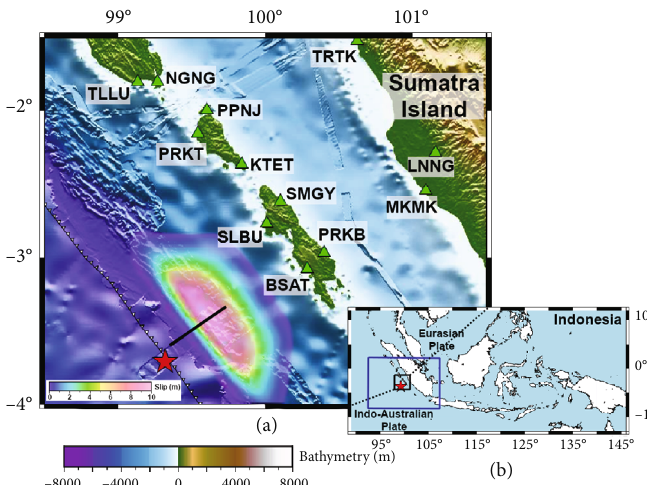
Figure 1: Maps of the study area. (b) The map of Indonesia in general. Our study area is the Sumatra subduction in the western part of Indonesia. The blue rectangle shows the size of the model used in our simulation. Our focus study area (a), the Mentawai segment, shown in black rectangle on the map (b). The red star indicates the epicenter of the 2010 Mentawai earthquake. The green triangles are the SuGAR GPS station which the data are used for this study. The coseismic slip model used in this study is from Hill et al. [35]. The black line is the cross-section used for Figure 7. The scale bar at the bottom of the map shows the scale of the bathymetry and the topography in meters.